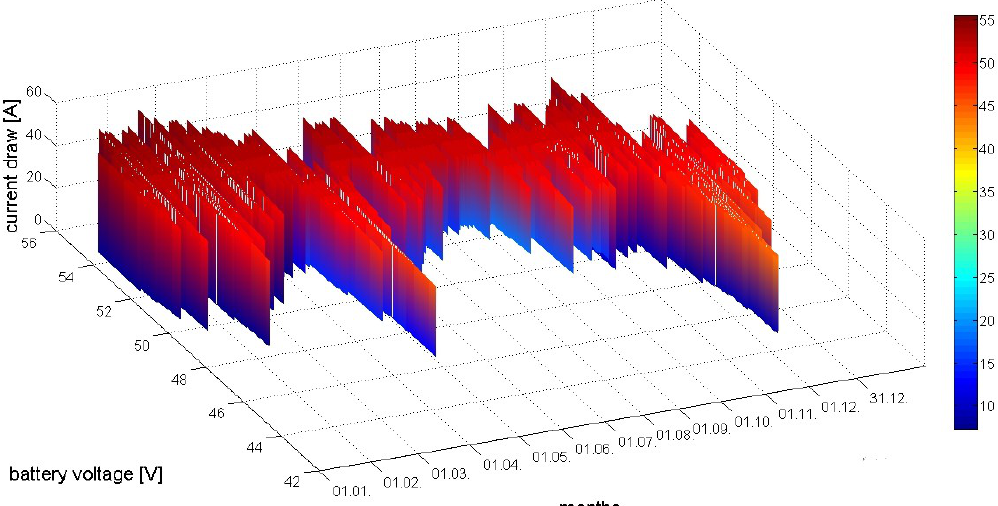
Figure 7. 3D visualization of interdependence among battery voltage and the total current draw for the BSS A during one